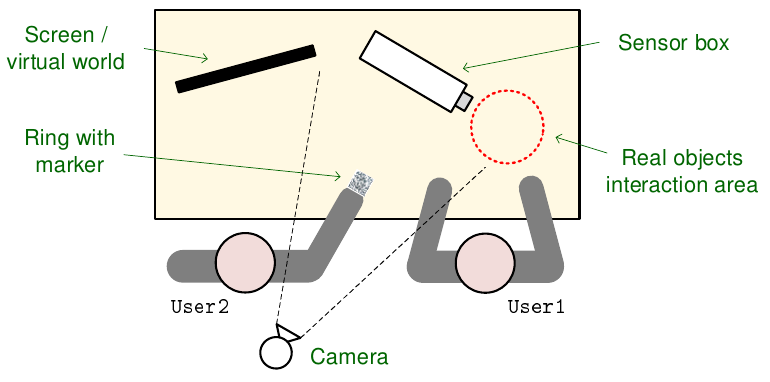
Figure 9. Spatial